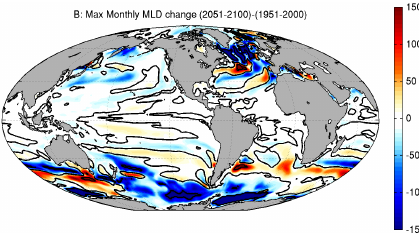
Figure 6. Estimated percent of MESOZP change based on the ap- proximation in Eq. (1). The correlation with the exact solution (Fig. 3b) is 0.98. Contours are shown at − 50, 0 and +